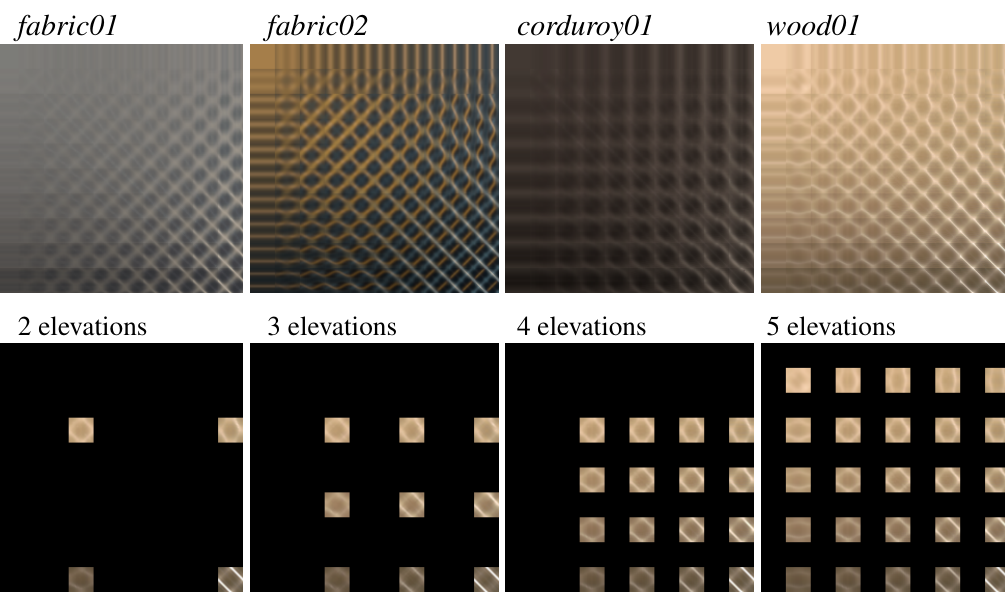
Figure 10. Tested BRDFs of fabrics and wood ( top ), and example of sampled BRDF subspaces at four different tested sets of elevations ( bottom